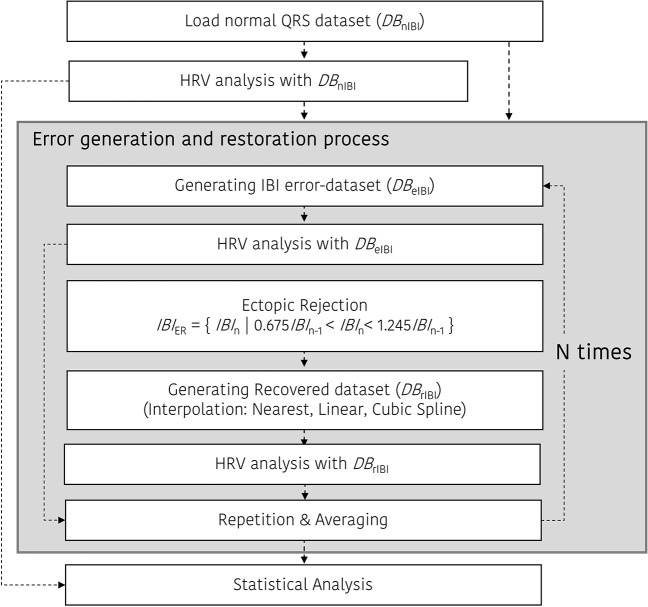
Ectopic-HRV simulation protocol.